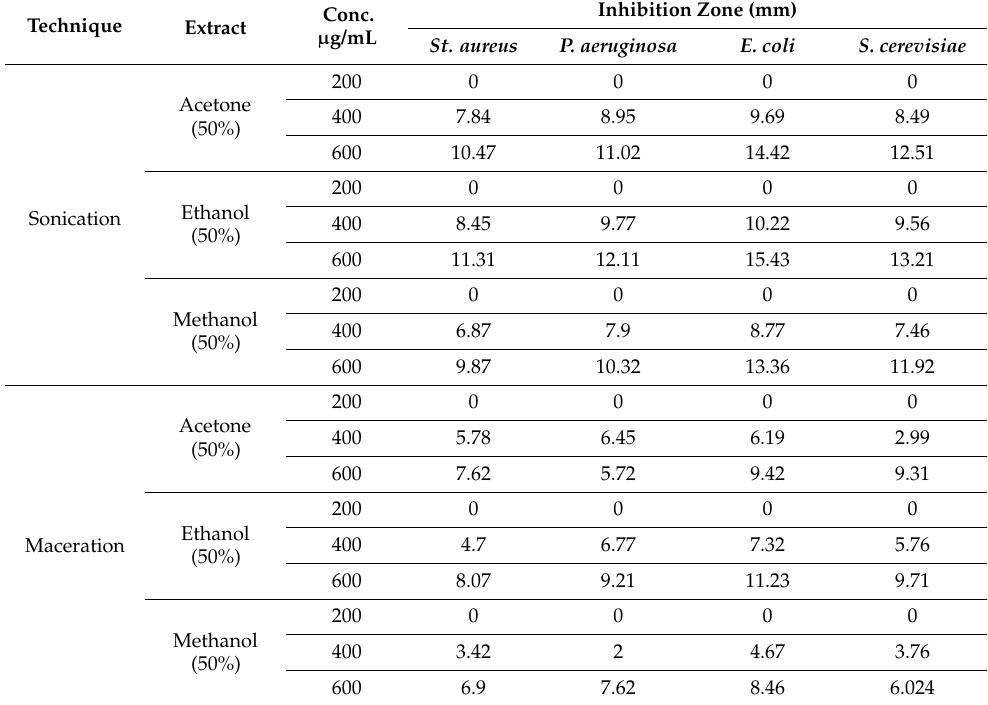
Table 3. Antimicrobial Activity of Banana Peel